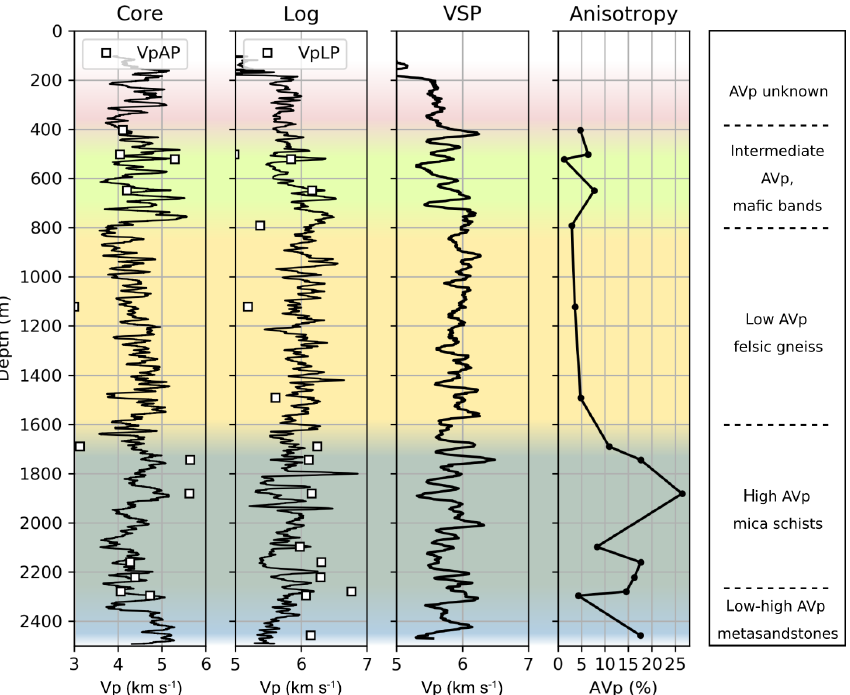
Figure 13. Upscaled core, log, and borehole seismic (VSP) velocities together with the laboratory-derived anisotropy–depth profile. Core and downhole logging velocities are smoothed over a 10m average and superimposed by the mean sample velocities (markers) calculated at atmospheric (VpAP) and lithostatic (VpLP) pressure. The anisotropy profile is linearly interpolated (see also Fig. 9). The colored sections highlight characteristic velocity zones based on the resultant data sets shown